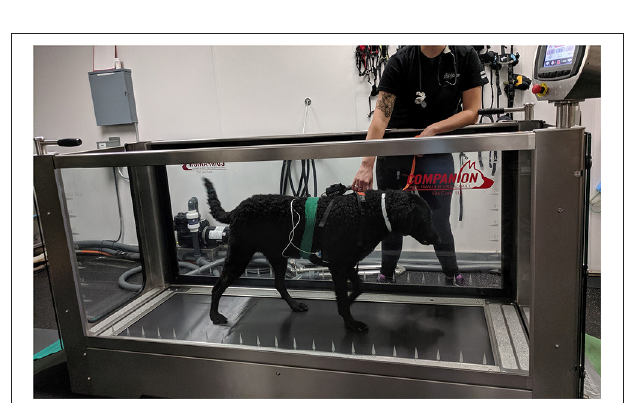
FIGURE 2 | Dog equipped with both monitors while on the